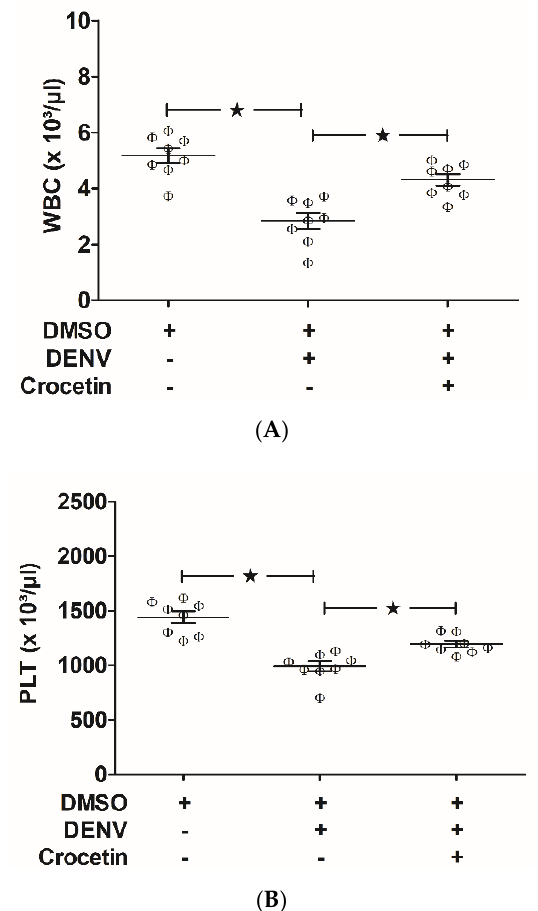
Figure 2. Crocetin improved leucopenia and thrombocytopenia in DENV-infected mice. BALB/c mice were infected with DENV-2 (4 × 10 5 FFU/mL) and treated with crocetin (50 mg/kg) dissolved in 2% DMSO. DENV-infected 2% DMSO-treated and mock-infected 2% DMSO-treated groups of mice were used as positive and negative controls, respectively. Blood samples were collected on day 7 post- infection for clinical hematology analysis. White blood cell (WBC) count ( A ) and platelet (PLT) count ( B ) are shown. The black star represents, those groups were compared and found to be significant.